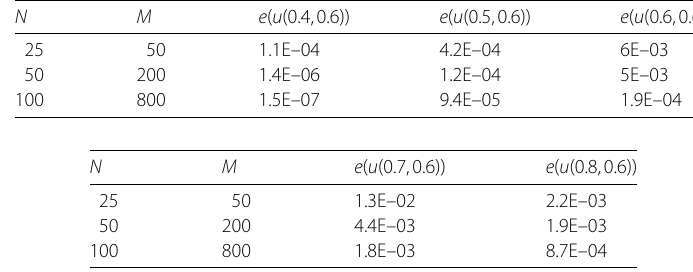
Table 3 The absolute error